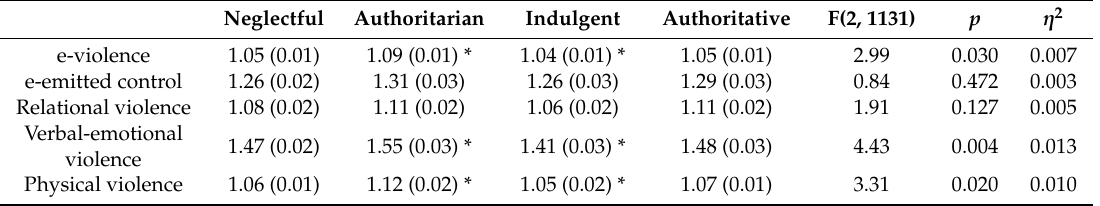
Table 6. Means, standard deviations (in brackets), F values, p values, e ff ect size, and post hoc Bonferroni